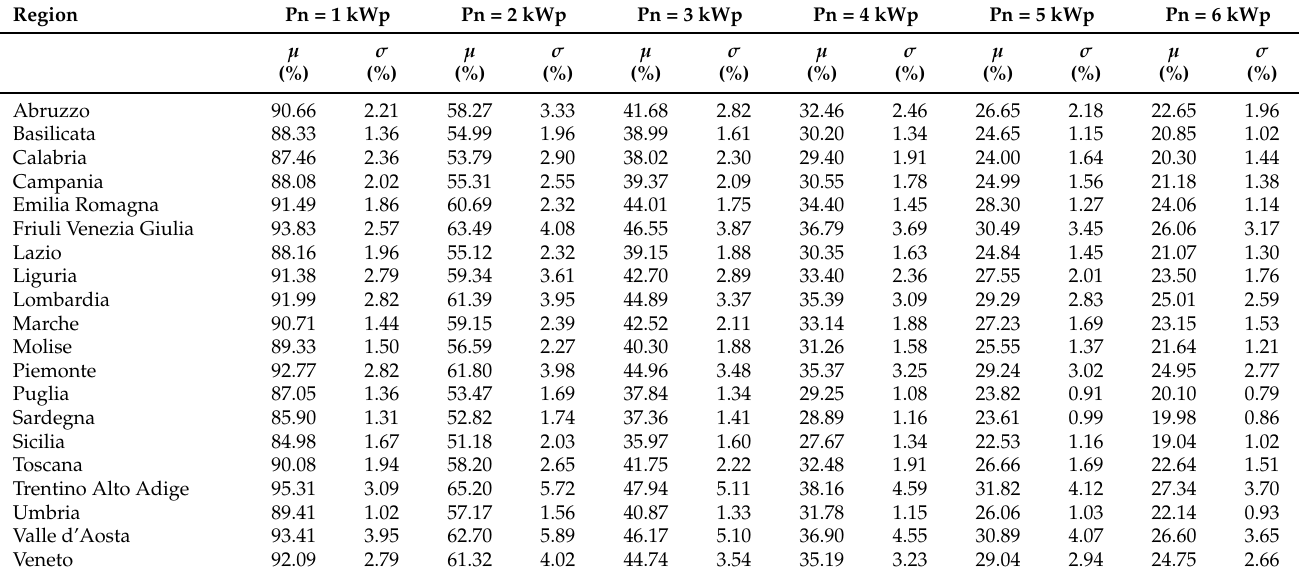
Table 22. Self-Consumption for E L = 4000 kWh without